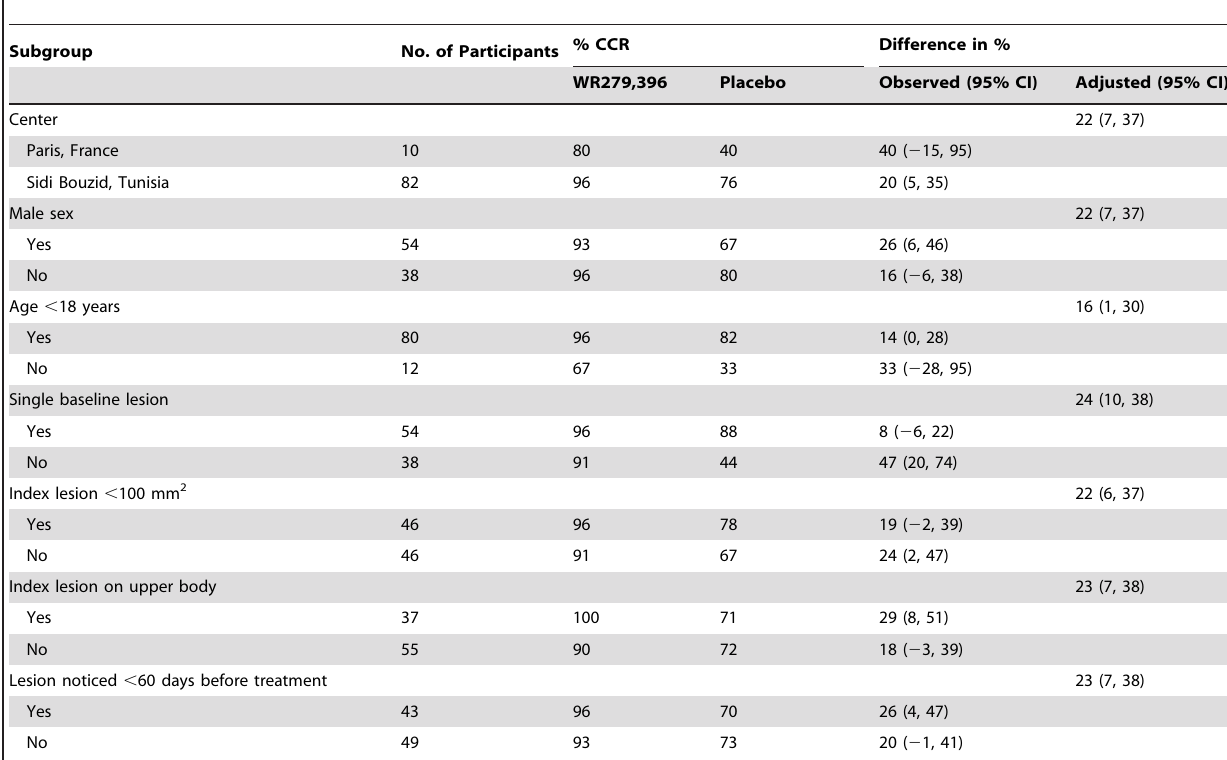
Table 3. Complete Clinical Response (CCR) at the Index Lesion According to Baseline Characteristics.